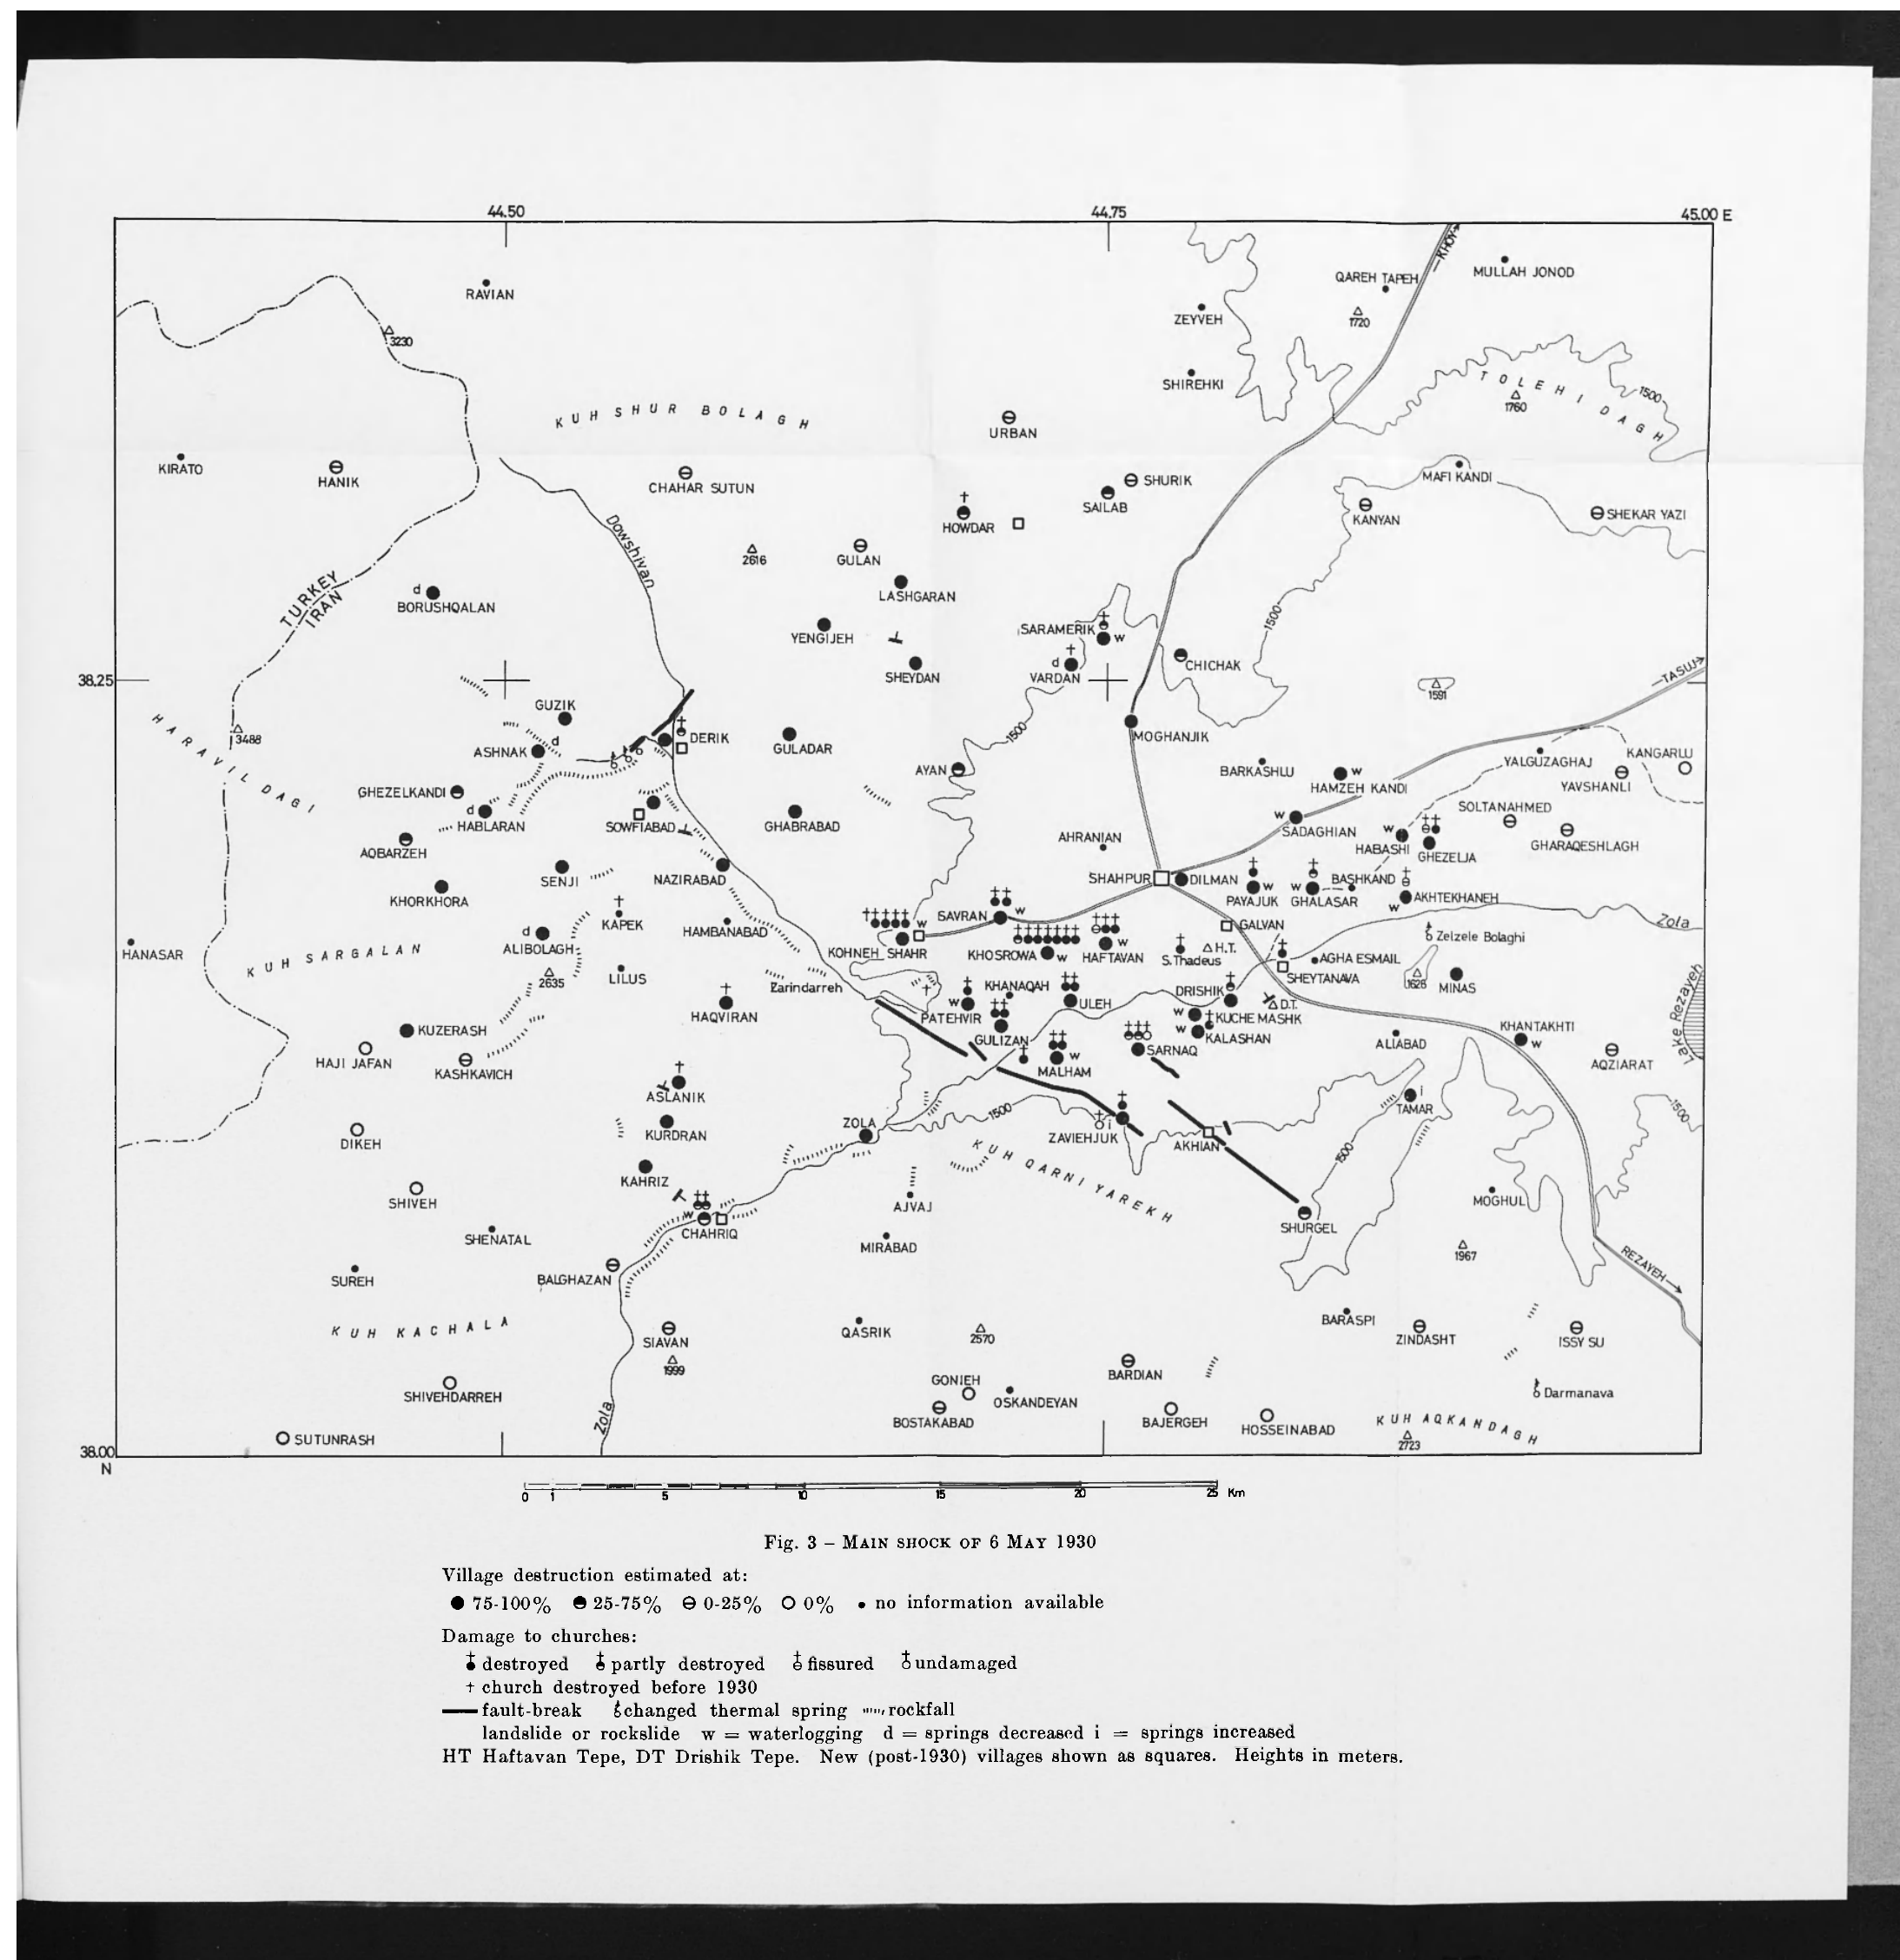
Fig. 3 - MAIN SHOCK OF 6 M AY